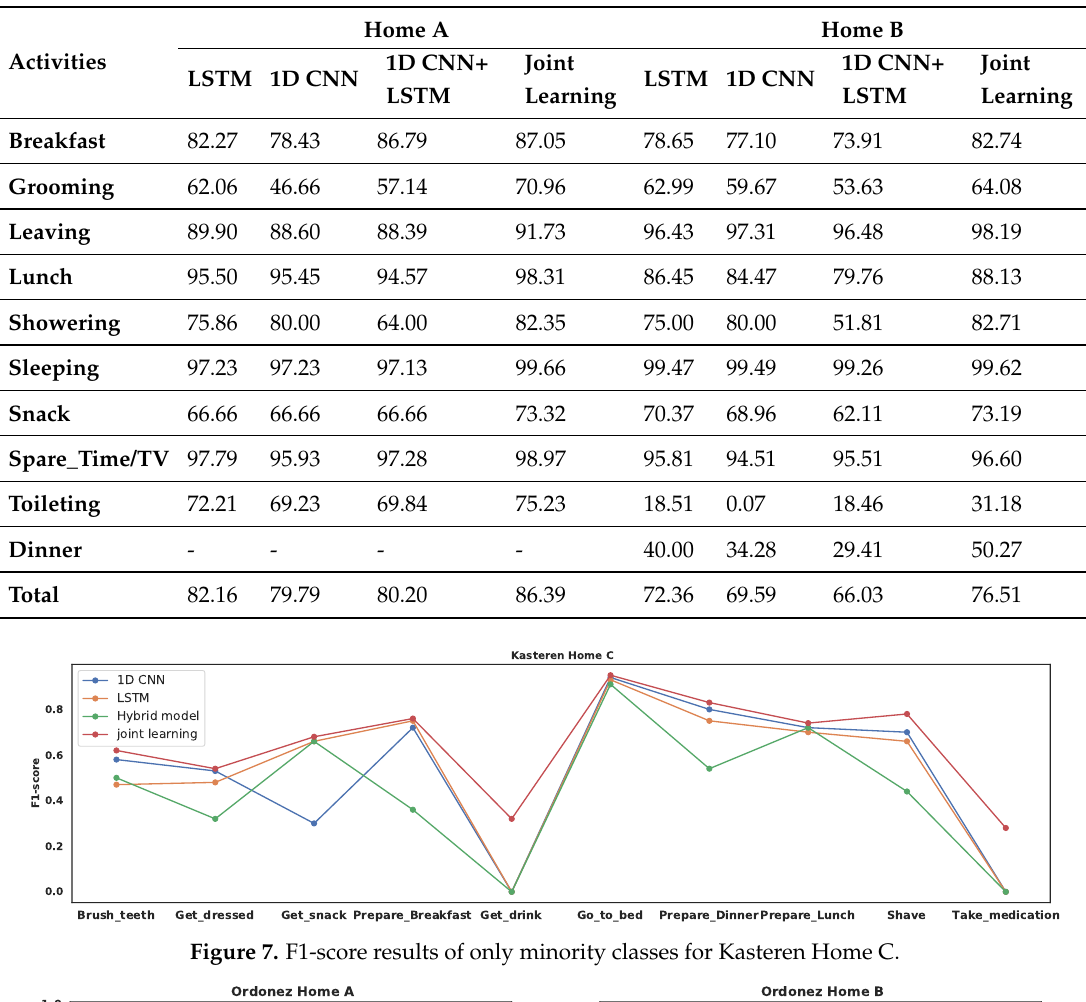
Figure 7. F1-score results of only minority classes for Kasteren Home C.